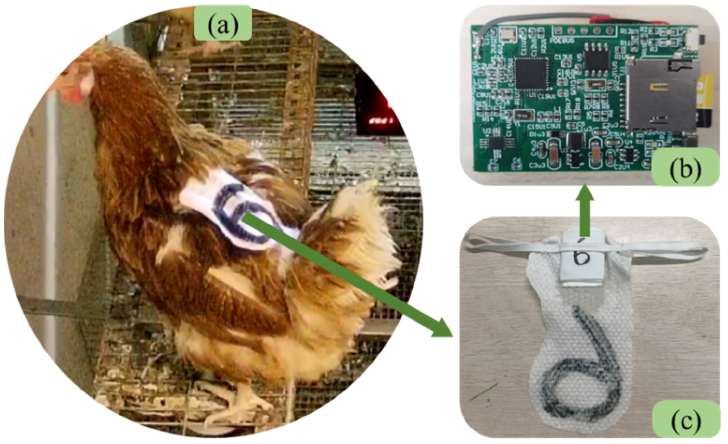
Figure 2. The photograph of ( a ) a laying hen wearing a backpack, ( b ) IMU sensors, and ( c ) the IMU backpack with figure-eight elastic loops.